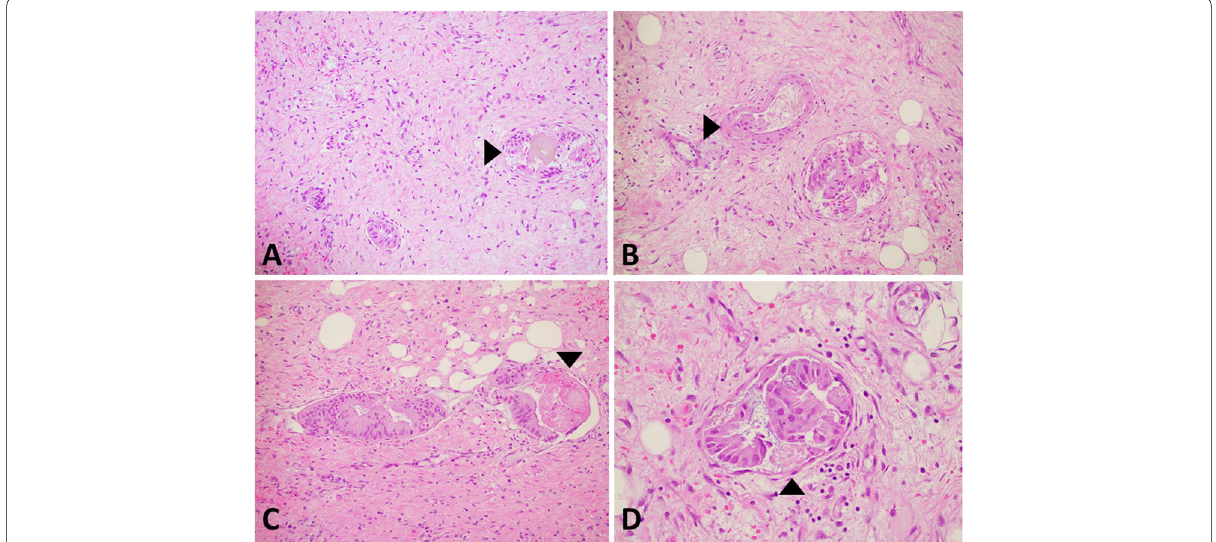
Fig. 1 Intravascular gallbladder epithelium. A Low magnification image showing multiple small thin-walled vessels with epithelial fragments. The intravascular inclusion on the right (arrowhead) is associated with biliary pigment. (H&E, 10X objective). B Medium magnification image showing intravascular epithelium within muscular (arrowhead) and non-muscular venules. (H&E, 20X objective). C and D High magnification of intravascular epithelium conforming to the shape of the vessel and associated with a fibrin thrombi (arrowheads). (H&E, 40X